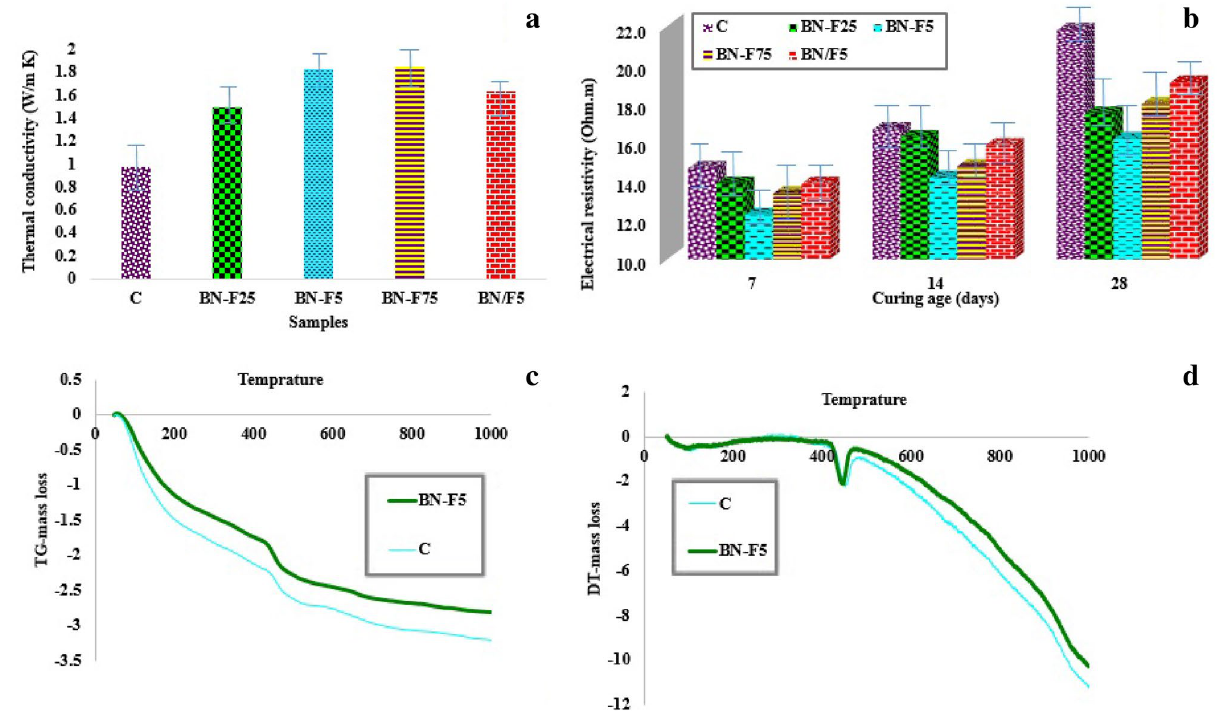
Figure 4. Thermal conductivity at 28 days of hydration ( a ), electrical resistivity at different ages of hydration ( b ), TGA/DTA results ( c , d ) at 28 days of hydration of the cement paste samples containing different amounts of BN–Fe 3 O 4